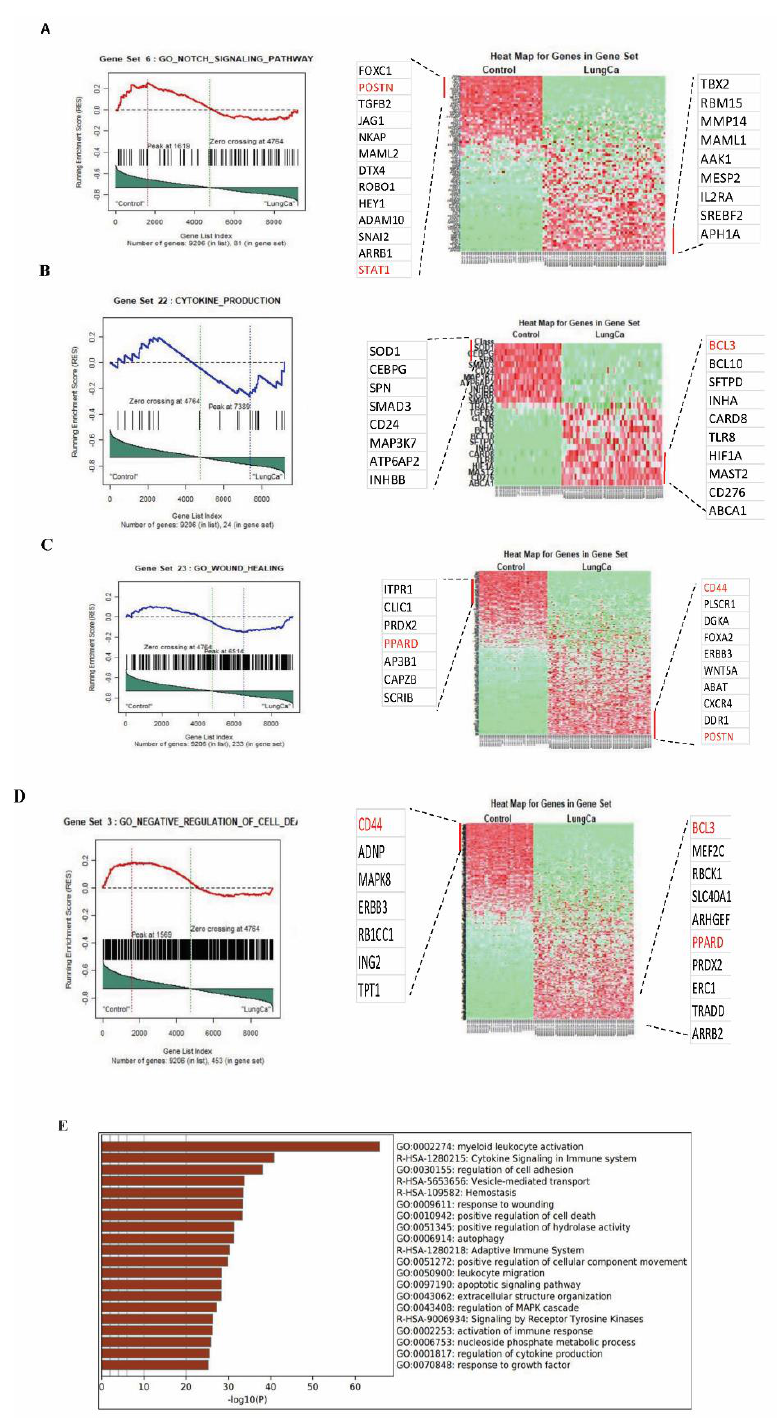
Figure 5. Gene set enrichment analysis (GSEA) of the differentially expressed genes between lung cancer bronchial epithelium ( n = 55) in GSE29013 and healthy bronchial epithelium ( n = 37) in GSE64913. ( A ) Notch signaling pathway, ( B ) cytokine production, ( C ) wound healing, ( D ) negative regulation of cell death (left panel shows the distribution of notch signaling pathway, cytokine production, wound healing, negative regulation of cell death according to their rank position. The right panel shows a heatmap illustration of their expression between lung cancer and healthy control). ( E ) The top enriched pathways, whether upregulated or downregulated in lung cancer, compared to healthy controls using metascape (http://metascape.org last access date 15 January 2022): a gene annotation and analysis online resource that generates a graphical